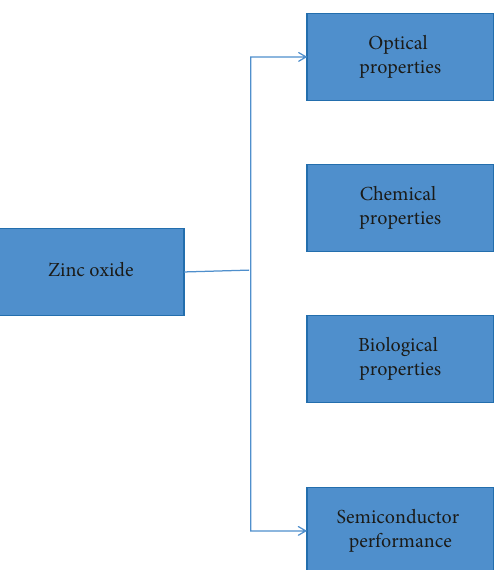
Figure 2: Function of nano-zinc